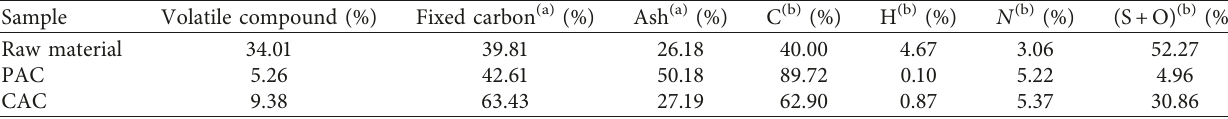
Table 1: Results of short and elemental analysis of activated carbon samples.